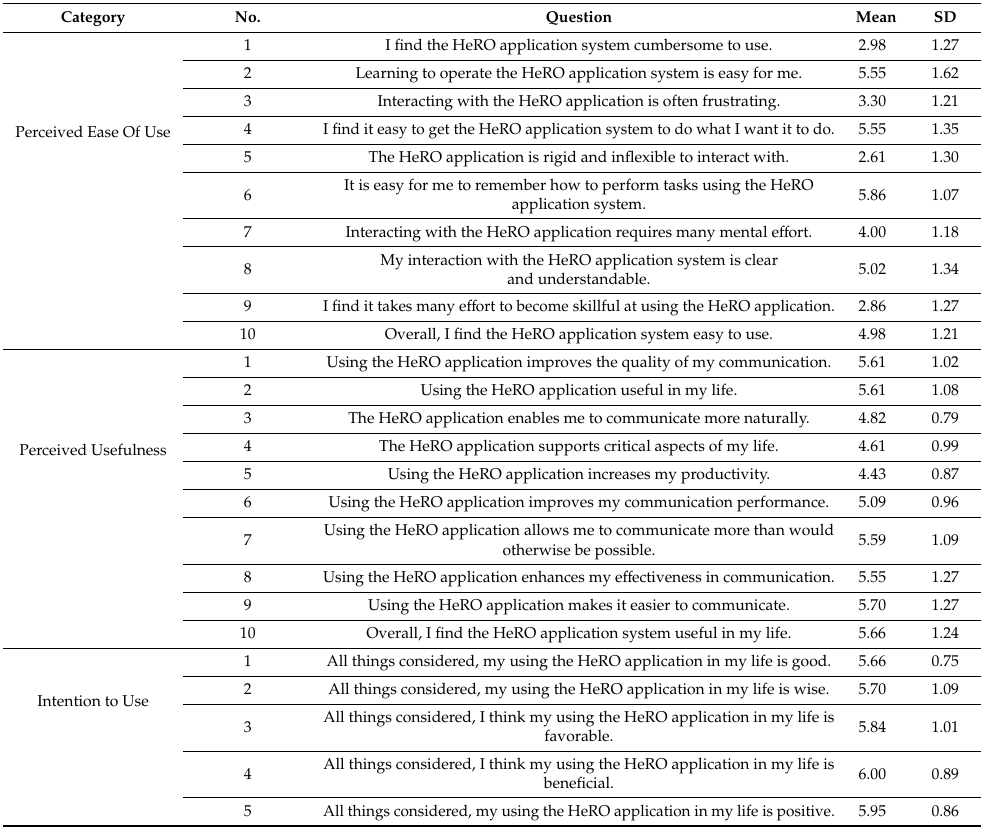
Table 1. Group mean scores and standard deviation for original items of technology acceptance model questionnaire.